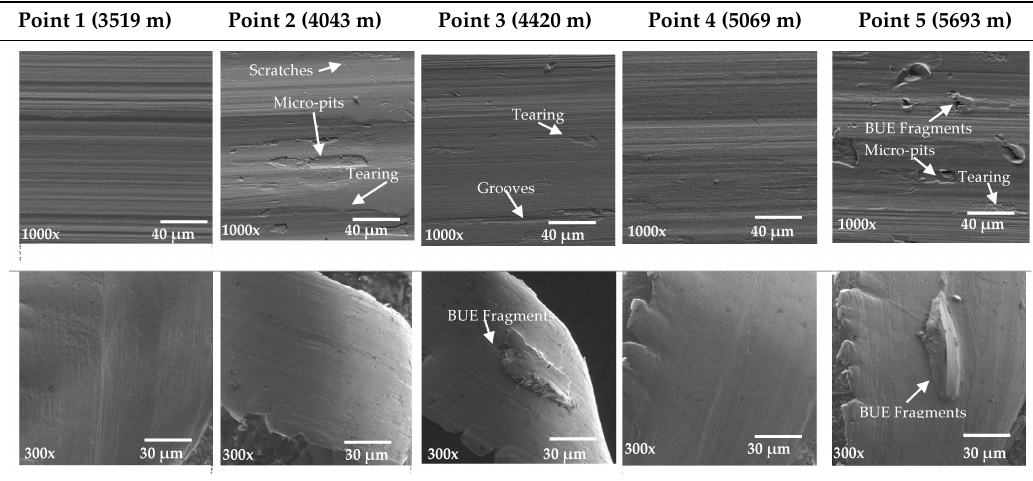
Figure 7. Relation between average surface roughness (Ra) and cutting length during steady state zone. Table 4. Machined surface and chip undersurface of five selected points in the steady state zone.